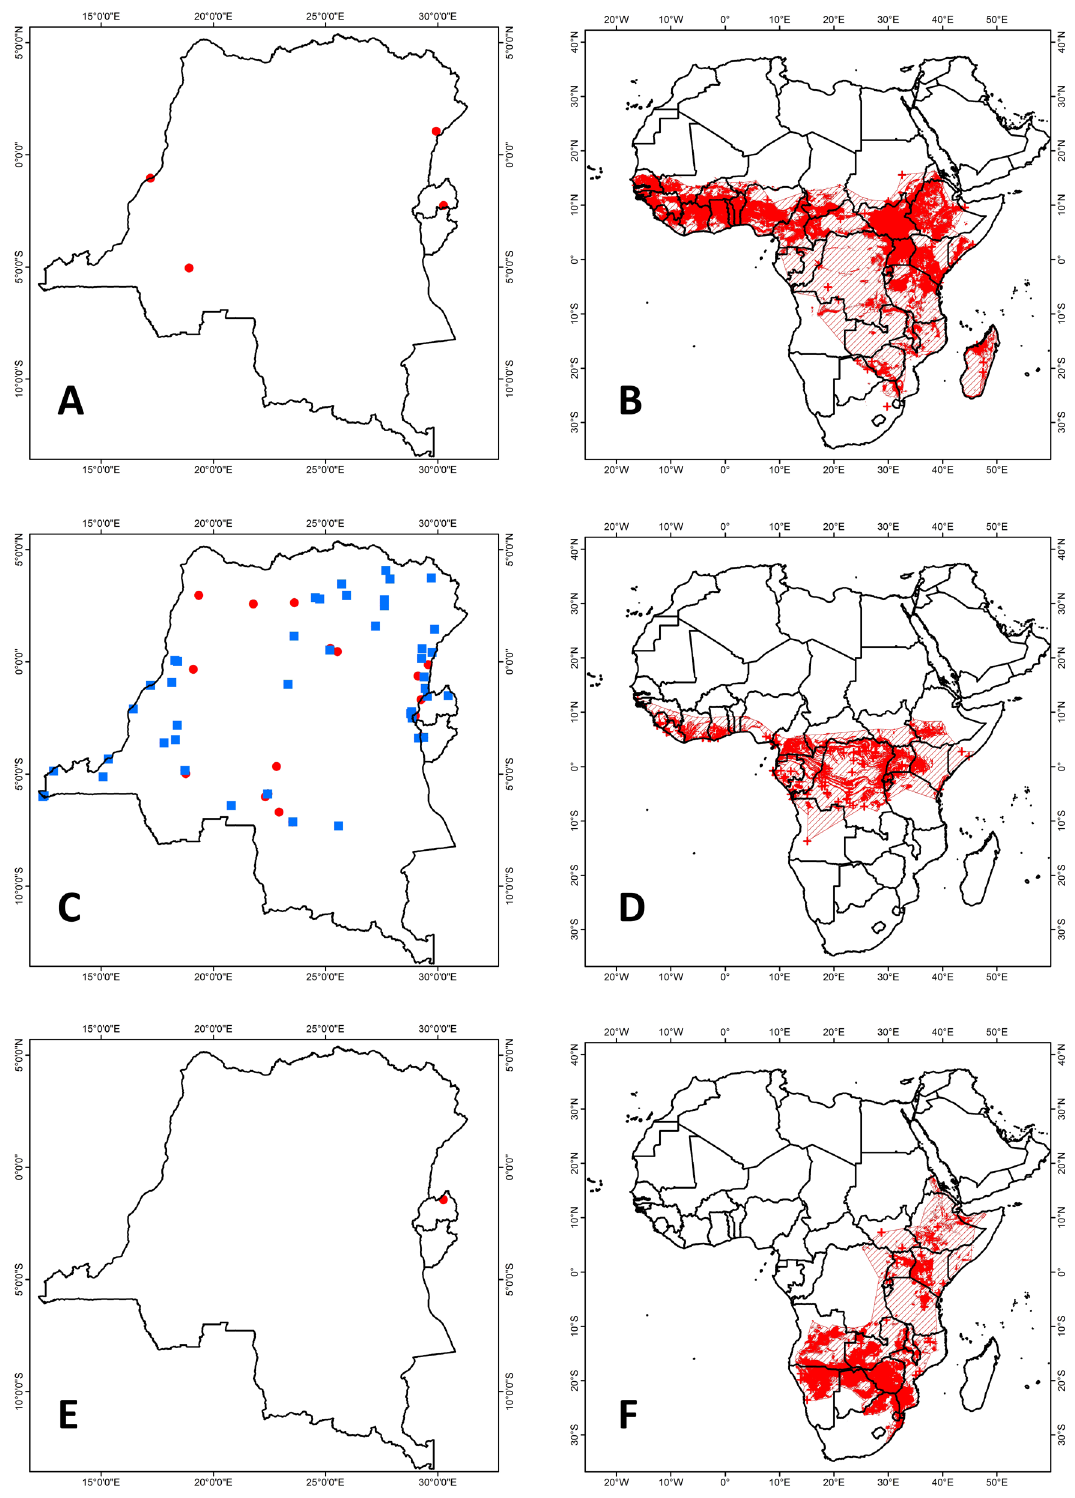
Fig. 45. Distribution maps. A–B . Neoromicia somalica (Thomas, 1901). C–D . Neoromicia tenuipinnis (Peters, 1872). E–F . Neoromicia zuluensis (Roberts, 1924). A, C, E. Distribution in the CRB area. B, D, F. Pan-African